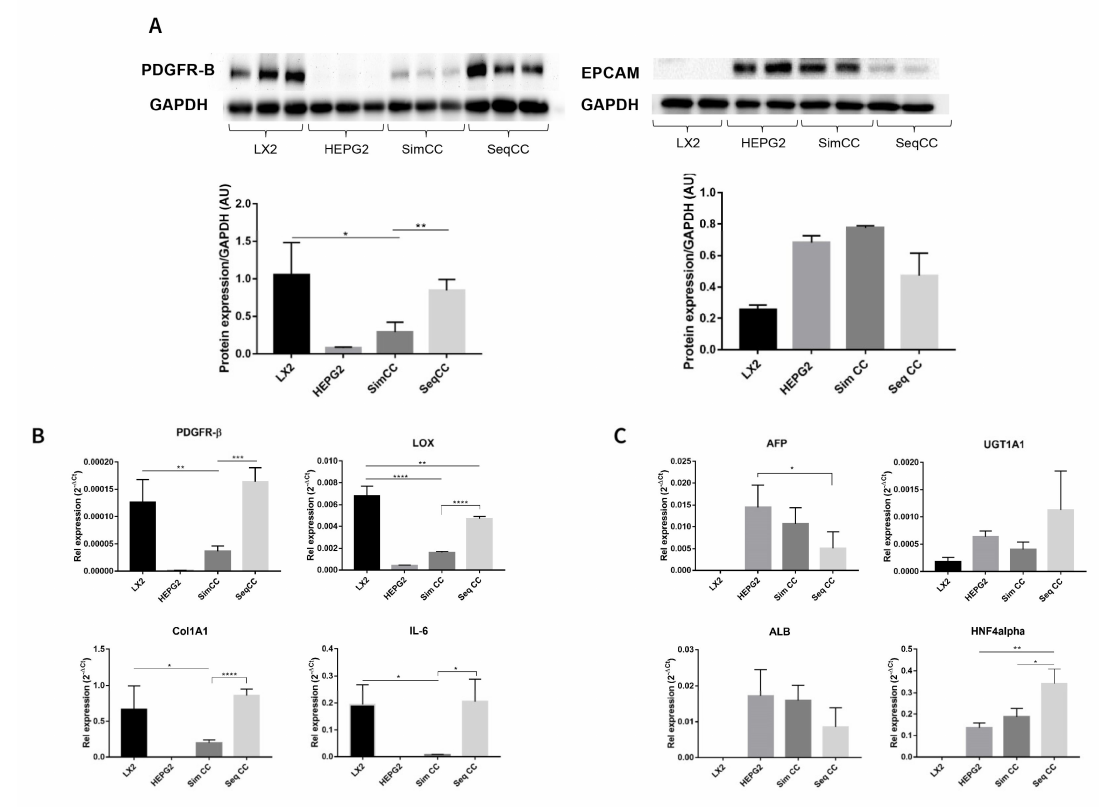
Figure 2. Characterization of mono-culture and co-culture of LX2 and HepG2 cells in 3D human healthy liver scaffolds. ( A ) Western blot and densitometry analysis of PDGFR- β and EPCAM protein expression of LX2 and HepG2 cells in single culture, simultaneous (SimCC), and sequential co-culture (SeqCC) (AU arbitrary units). ( B ) mRNA expression of genes related to pro-fibrogenesis and inflammation. ( C ) mRNA expression of genes related to hepatocellular carcinoma cell phenotypes and hepatocyte-specific functions. ( n = 4 scaffolds per condition, * p ≤ 0.05, ** p ≤ 0.01, *** p ≤ 0.001, and **** p ≤ 0.0001). (Figure S1: Whole blot showing all the bands with all molecular weight markers on the